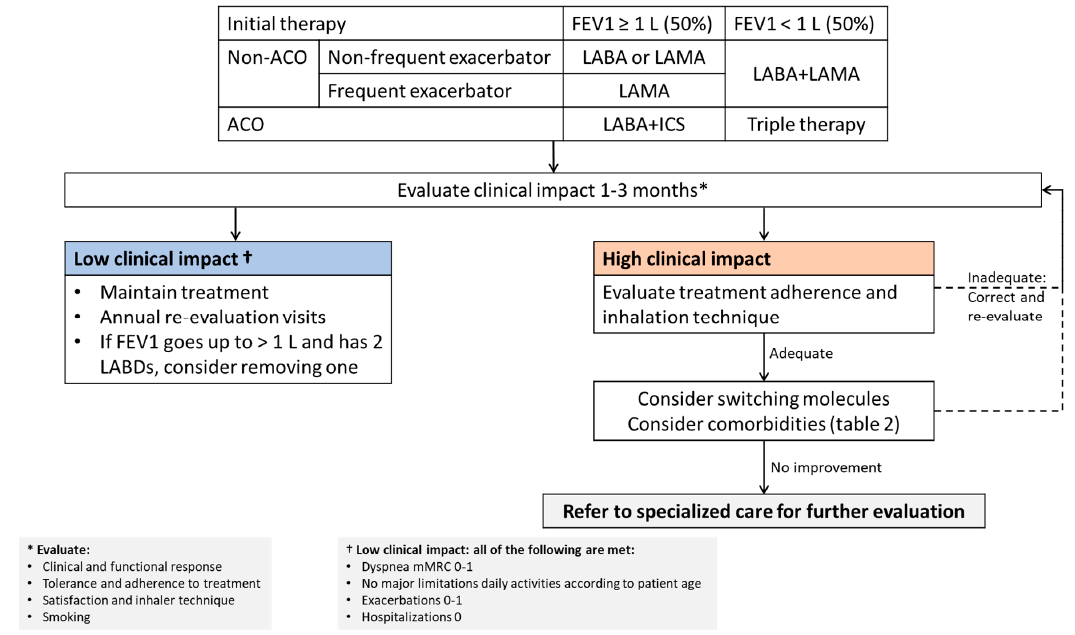
Figure 2. Proposal of initial pharmacological approach.